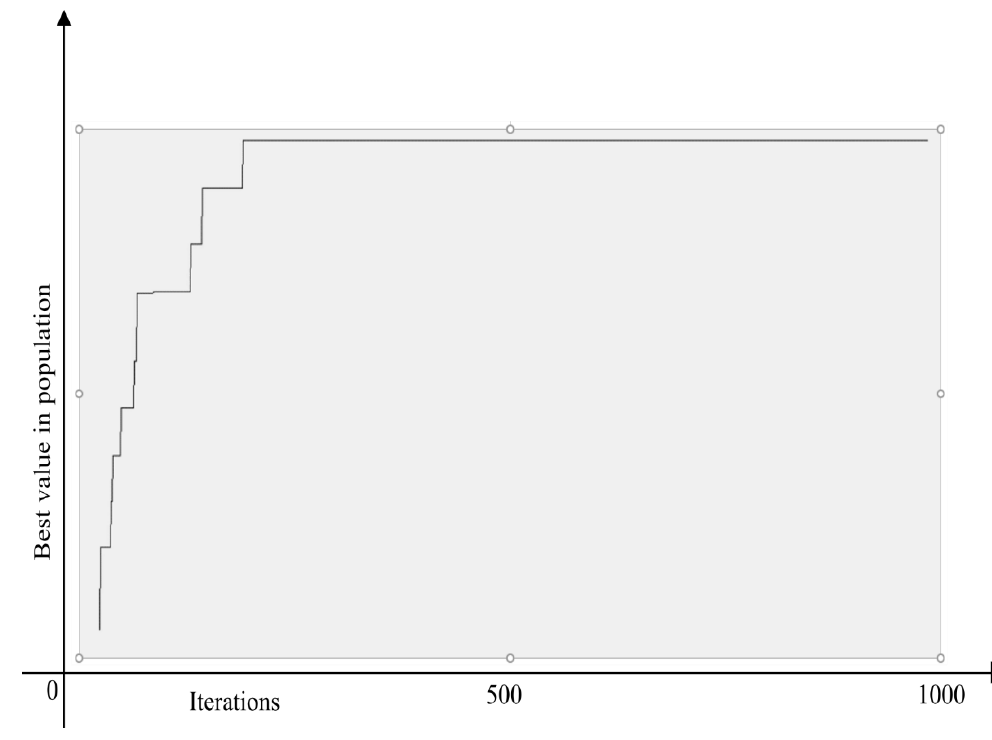
Figure 1. Value of fitness function by iterations.